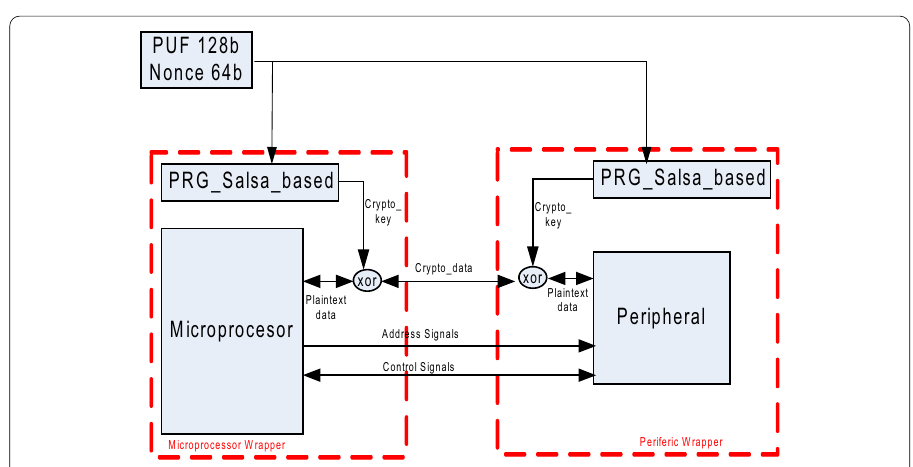
Fig. 3 Encryption Scheme between Microprocessor and